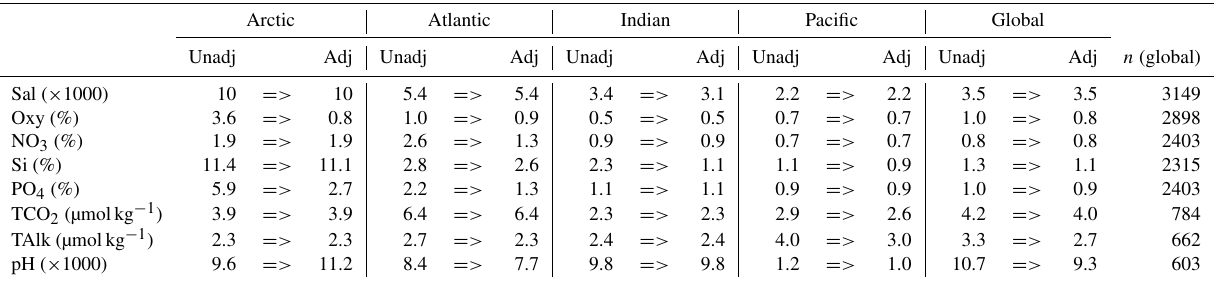
Figure 5. Distribution of applied adjustments for each core variable that received secondary QC. Grey areas depict the initial minimum adjustment limits. The figure includes numbers for data subjected to secondary quality control only. Note also that the y -axis scale is set to render the number of adjustments to be visible, so the bar showing zero offset (0 bar) for each variable is cut off (see Table 5 for these numbers). Table 7. Improvements resulting from quality control of the 116 new cruises, per basin and for the global data set. The numbers in the table are the weighted mean of the absolute offset of unadjusted and adjusted data versus GLODAPv2. n is the total number of valid crossovers in the global ocean for the variable in